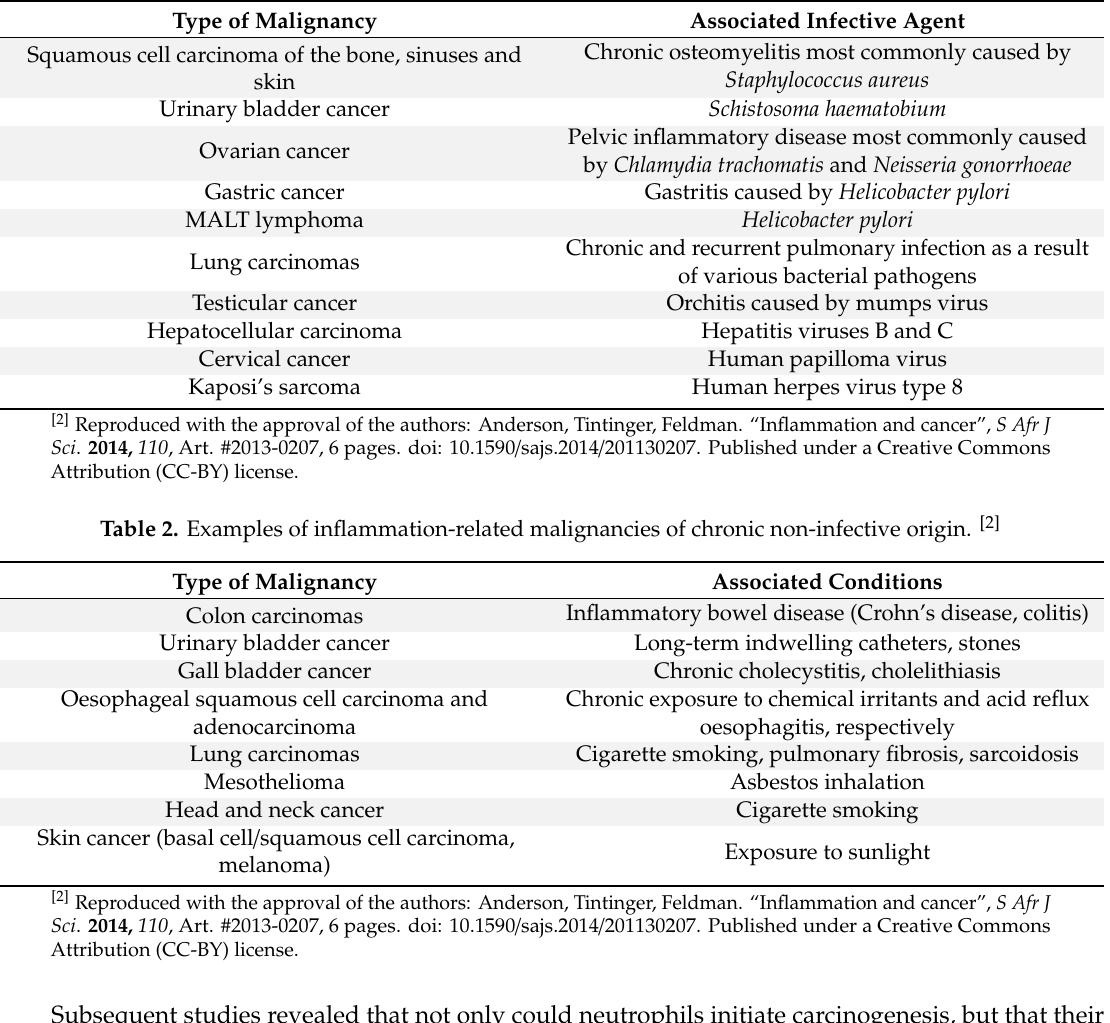
Table 1. Examples of inflammation-related malignancies of chronic infective origin. [2]